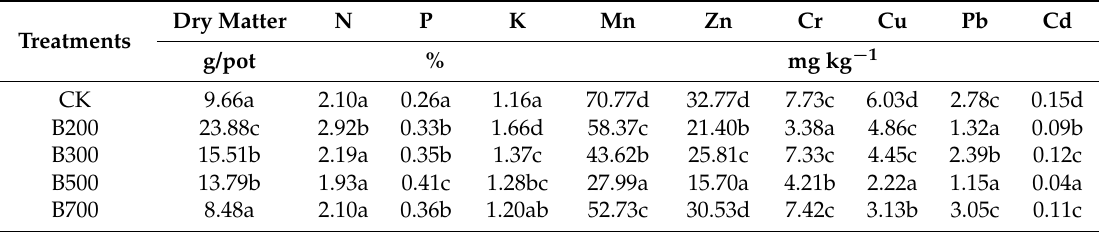
Table 5. The dry matter, NPK and heavy metals of the grass grown in the soils amended with the biochars derived from municipal sewage sludge at 200 ◦ C, 300 ◦ C, 500 ◦ C, and 700 ◦ C for 2 h in a muffle